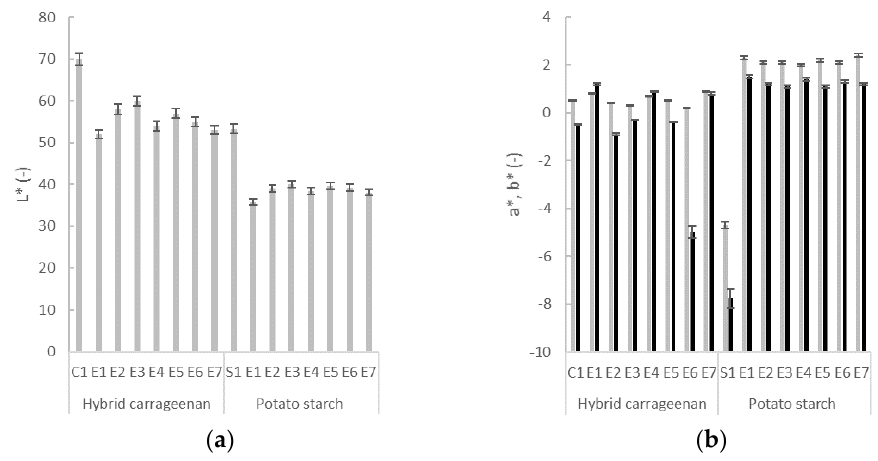
Figure 6. Color parameters for proposed matrices prepared with ( a ) hybrid carrageenan or potato starch in the presence of the selected extracts (E1–E7; see Table 1) compared with the controls (C1 and S1). The gray and black bars in the plot ( b ) correspond to the a* and b* parameters, respec- tively.